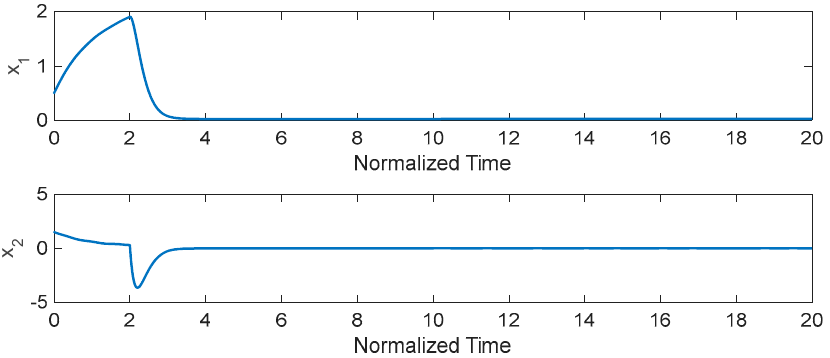
Figure 6. Results of the vibration suppression based on the proposed method in the presence of disturbances and faults in the actuator.